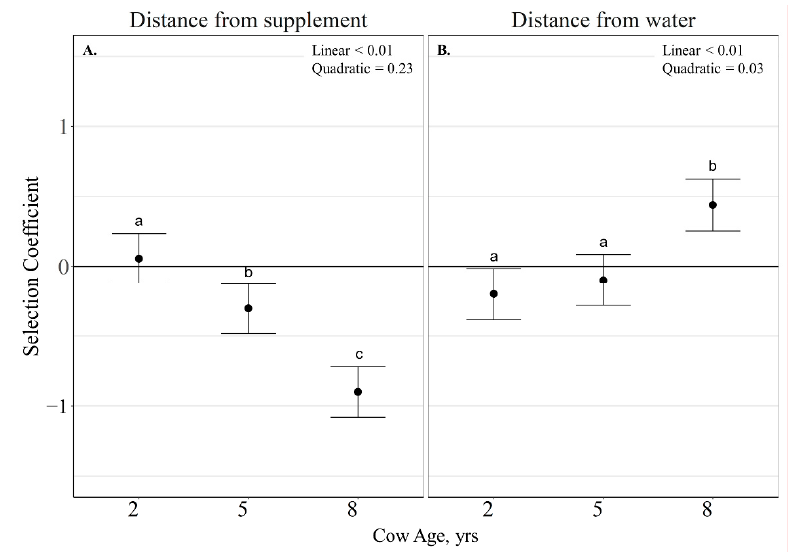
Figure 8. Influence of cow age on distance from supplement ( A ) and distance from water ( B ; expressed as slope estimate ± CI) of cattle grazing dormant northern mixed-grass prairie in 2018/2019 and 2019/2020 at the Northern Agriculture Re- search Center’s Thackeray Ranch, Havre, MT, USA. Means lacking common letters (a, b) differ ( p < 0.05). Core grazing area (ha) was linearly affected by cow age ( p < 0.01), with core grazing area decreasing with increasing cow age (Figure 9). There was no effect of RFI on core grazing area ( p = 0.71), but a tendency for a cow age × RFI interaction was observed ( p = 0.07). However, there were no differences observed for RFI within cow age ( p > 0.10) rela- tive to size of core grazing area.